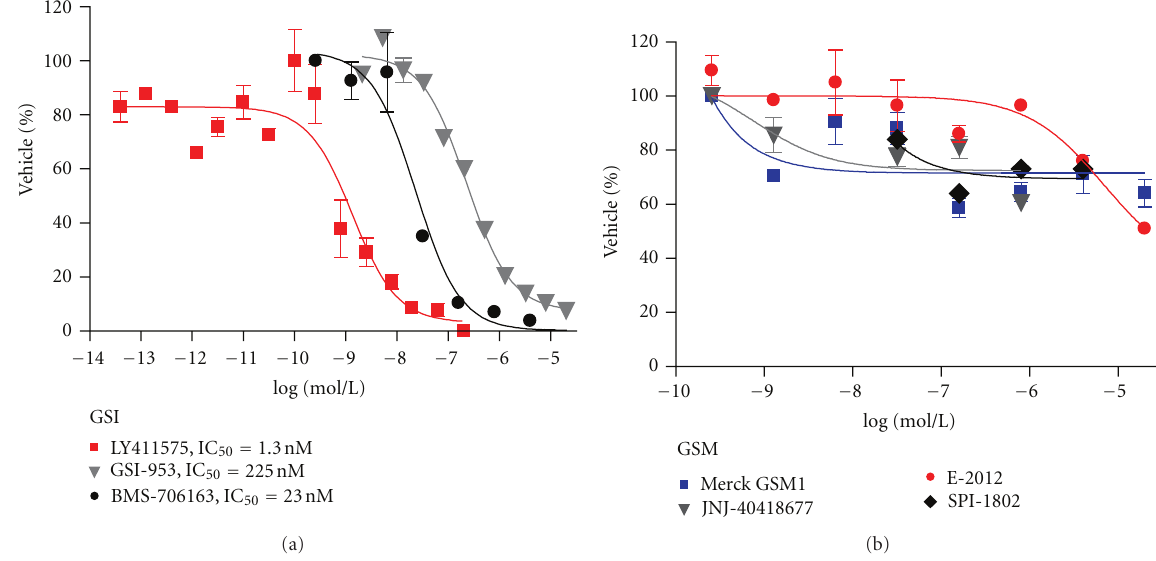
Figure 1: Multiple GSI and GSMs were examined in for their ability to inhibit NOTCH cleavage using the SUP-T1 cellular